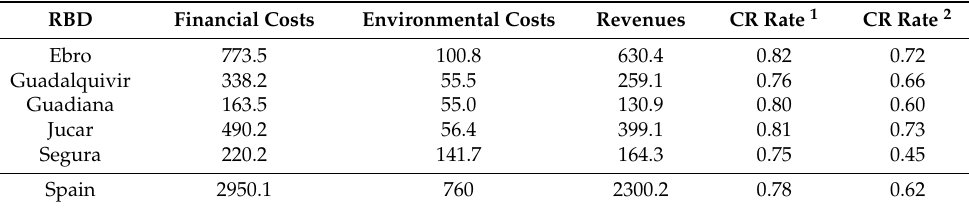
Table 3. Financial and environmental costs, revenues, and cost-recovery rates in agriculture in Spanish Mediterranean